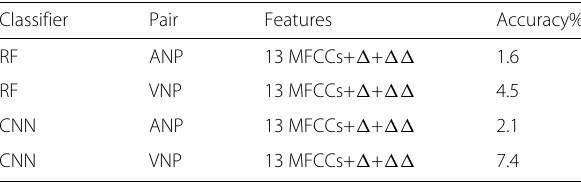
Table 6 Overall multi-class classification performance for random forest and CNN Classifier